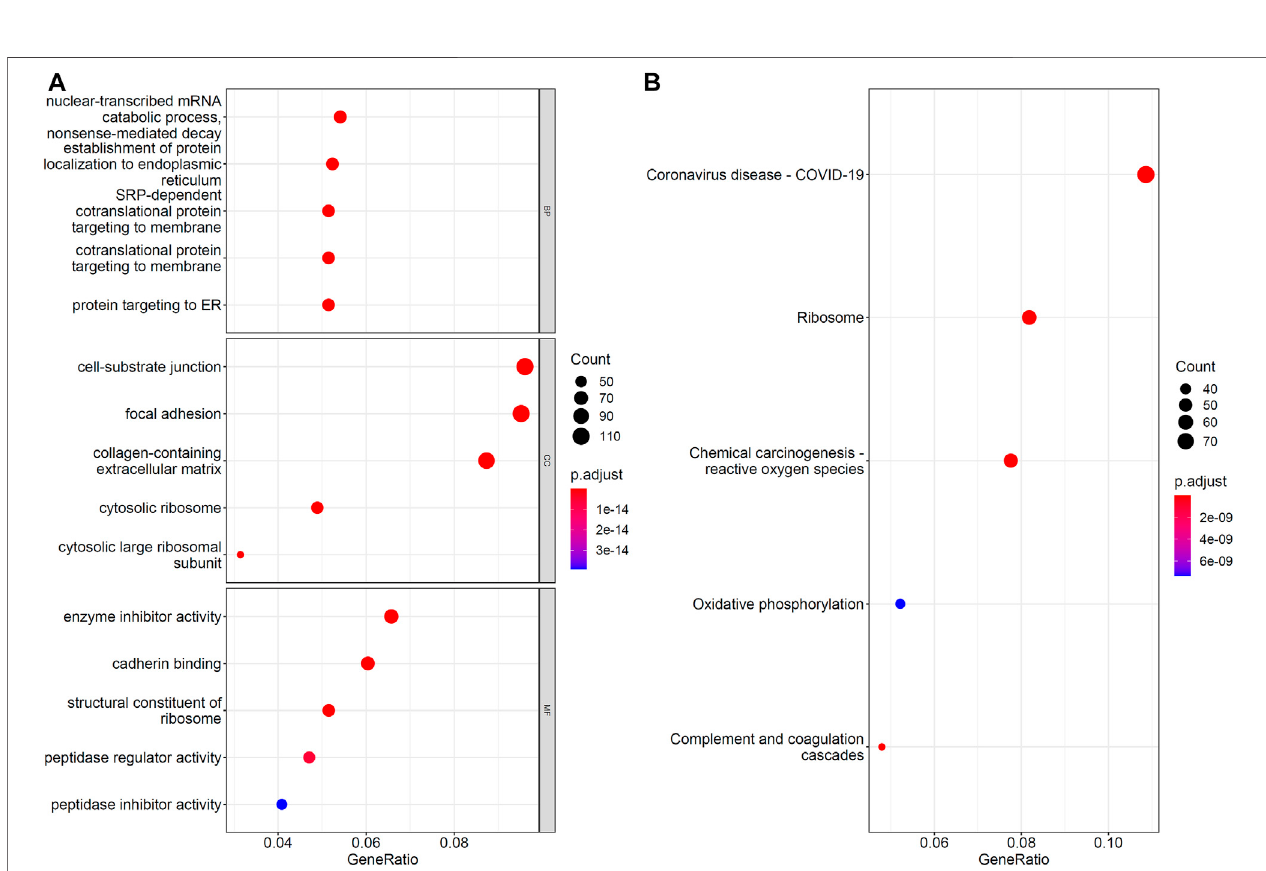
FIGURE 5 | Gene ontology and KEGG pathway enrichment analysis on optimal genes for RF. The FDR < 0.05 criterion was used to fi lter GO terms and KEGG pathways. (A) The top fi ve GO enrichment results for each GO group. (B) The top fi ve KEGG pathway enrichment results.